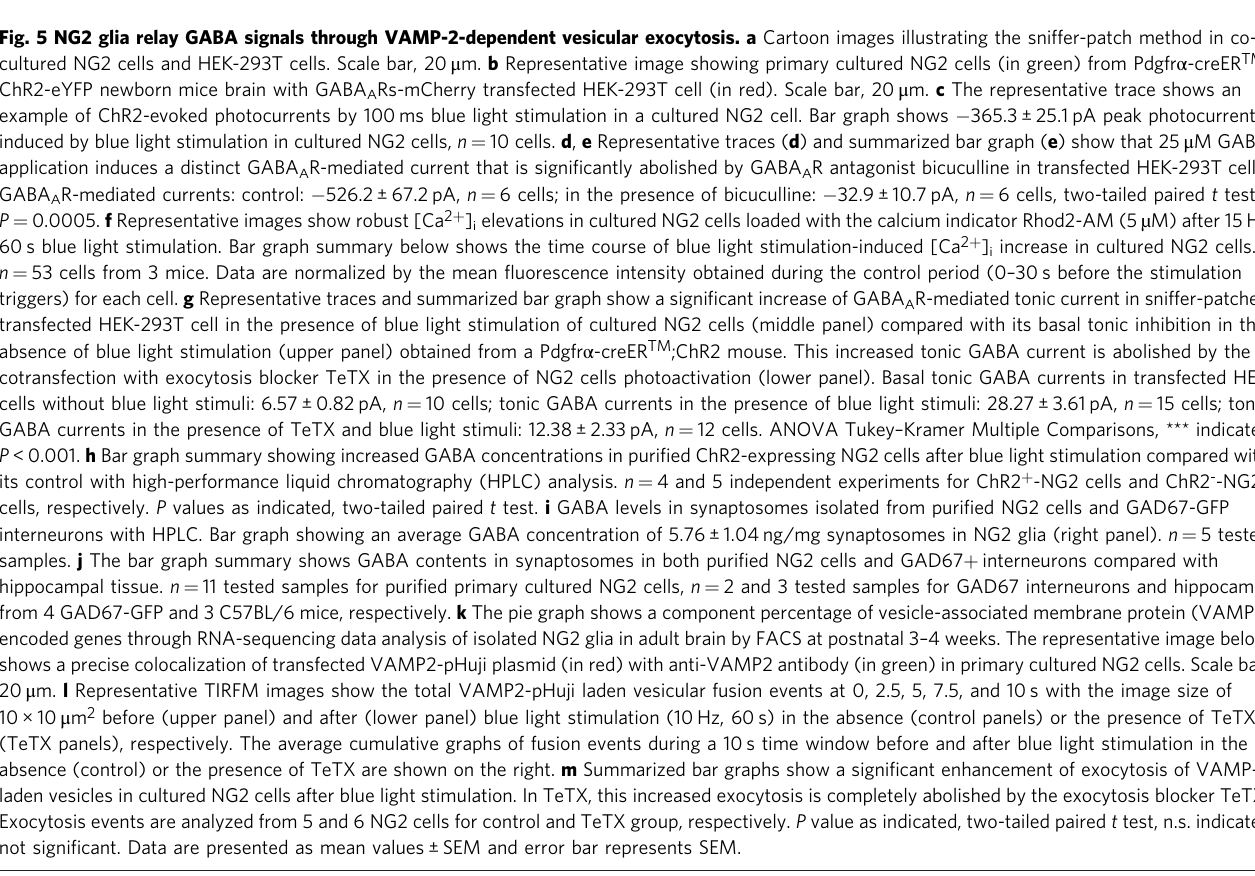
Fig. 5 NG2 glia relay GABA signals through VAMP-2-dependent vesicular exocytosis. a Cartoon images illustrating the sniffer-patch method in